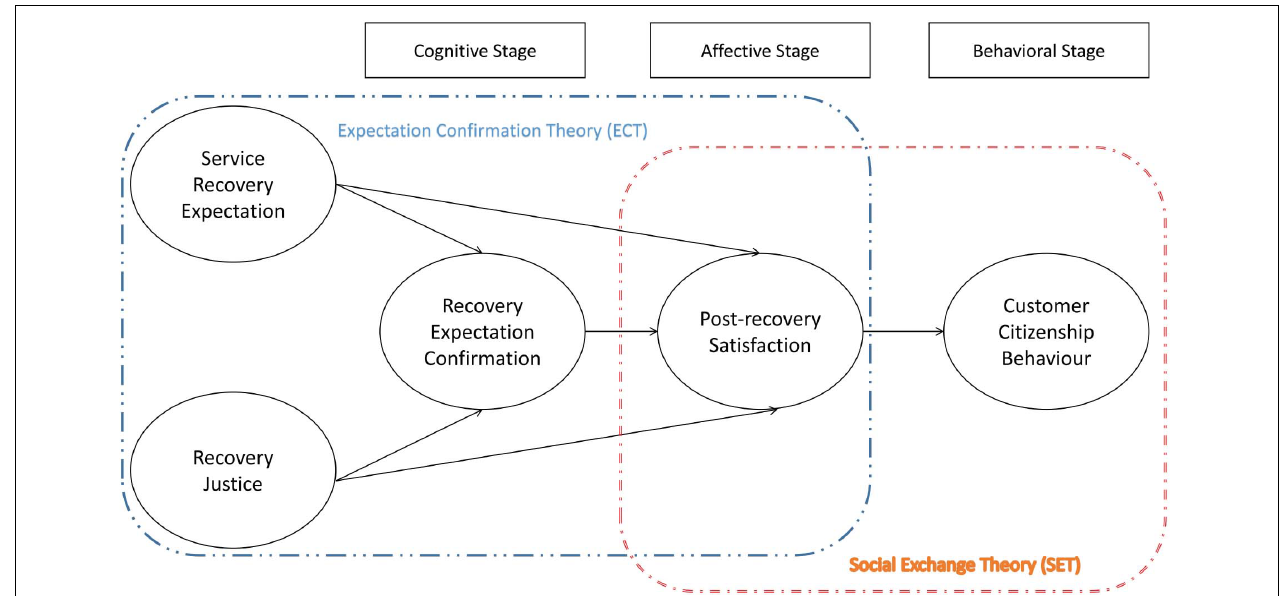
FIGURE 1 | Research model for understanding how service recovery expectation and justice link to customer citizenship